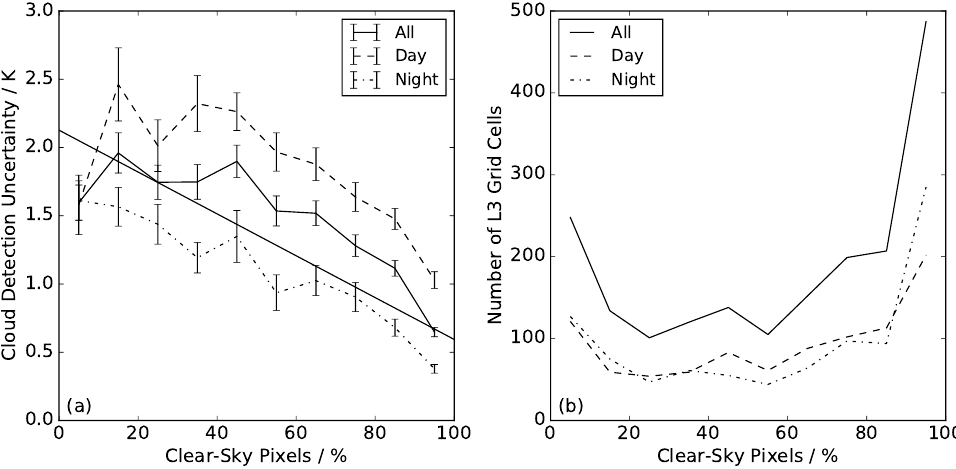
Figure 8. Cloud detection uncertainties as a function of clear-sky fraction ( a ) at 625-km 2 resolution. The following are shown: all data (solid line), night-time only (dot-dash line) and daytime only (dashed line). The linear regression for cloud detection uncertainty as a function of clear-sky percentages is shown for all data. Panel ( b ) shows the number of observations in each bin.